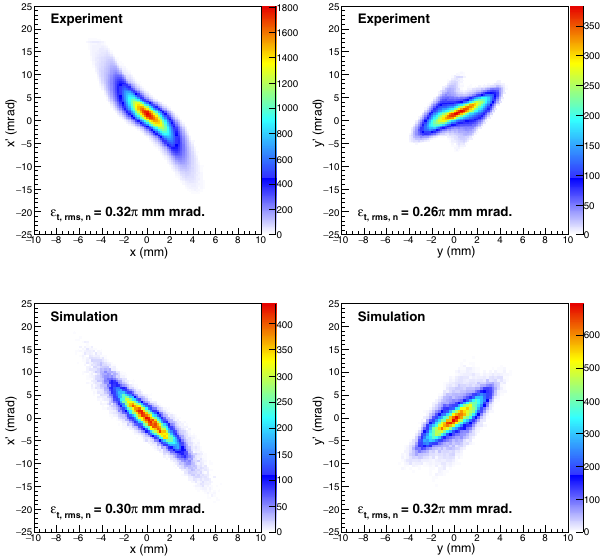
FIG. 11. Measured (upper row) and simulated (lower row) transverse emittances of